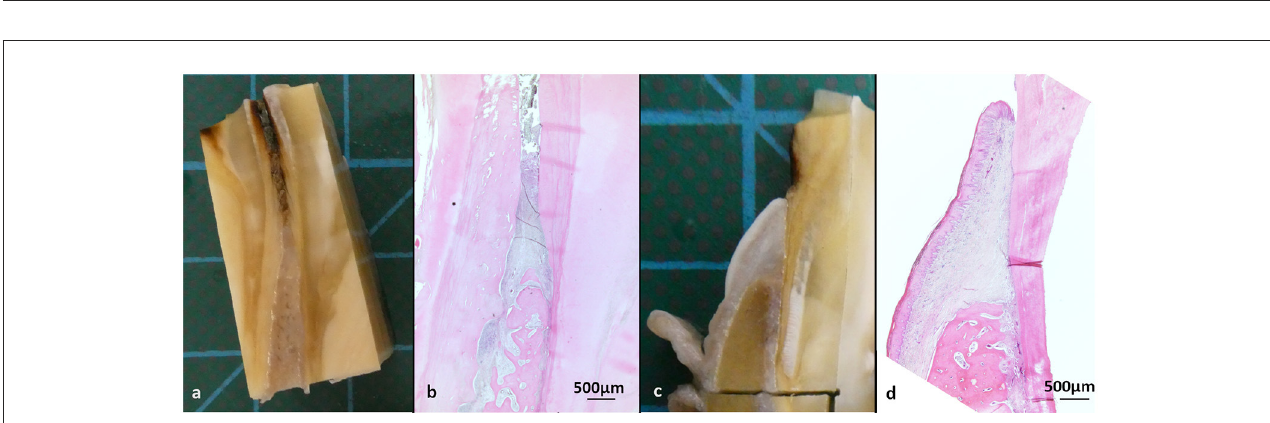
FIGURE2 Macroscopic and histological overview, stained with hematoxylin-eosin (HE). (a, b) Interdental ginigva sample between tooth 408 and 409 of a 29-year-old Icelandic mare (PPID). (c, d) Dental gingiva sample, cheek teeth 409 lingual aspect of a 19-year-old Icelandic mare (control).